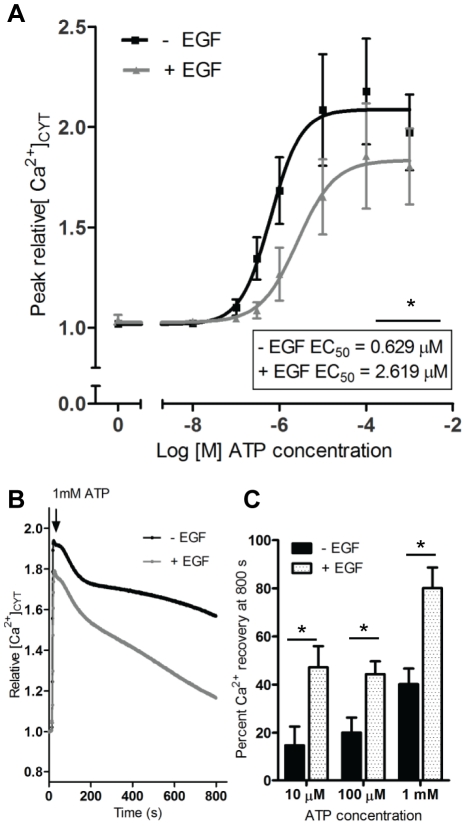
ATP signaling in non-adherent MDA-MB-468 cells following EGF treatment.A, assessment of [Ca2+]CYT in non-adherent MDA-MB-468 cells treated with EGF (24 h) following stimulation with various concentrations of ATP. Graphs represent the average dose response curves for measurement of peak relative [Ca2+]CYT and are shown ± S.D. The average EC50 values are shown inset and * represents the significance for EC50 values; P<0.05, unpaired t-test. B, the average [Ca2+]CYT transient for suspended cells stimulated with 1 mM ATP. C, Percent [Ca2+]CYT recovery ± S.D. at the end of the assay (800 s) was assessed using 10 µM, 100 µM and 1 mM of ATP. Statistical analysis was performed using two-way ANOVA with Bonferroni post-tests; * signifies P<0.05. Values are representative of 12 wells from 3 independent experiments.